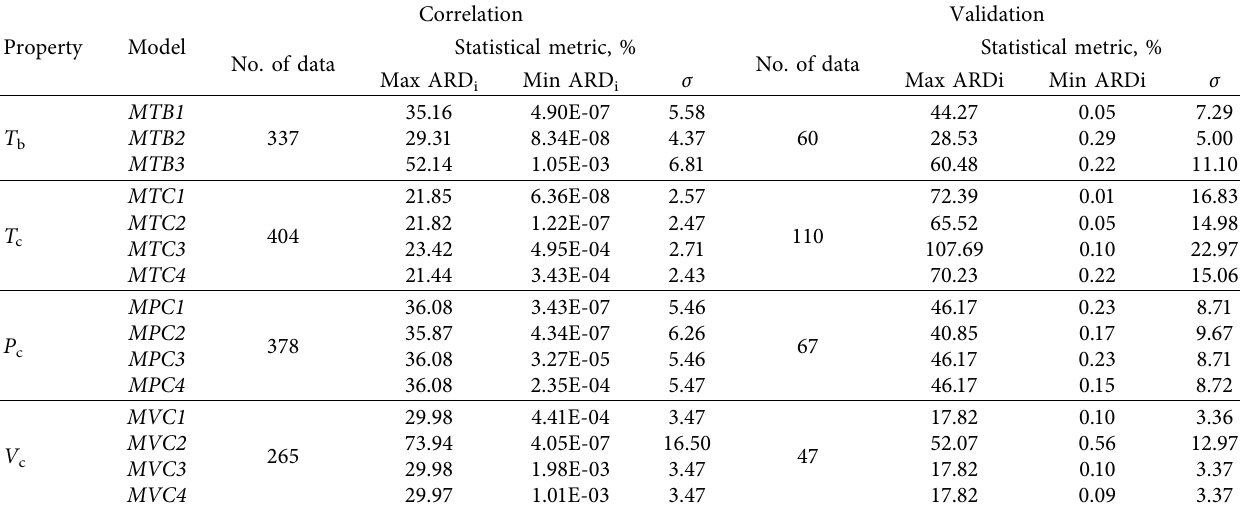
Table 3: Results of statistical metrics used to compare the performance of first-order GCMs for the calculation of critical properties and normal boiling point of pure compounds.